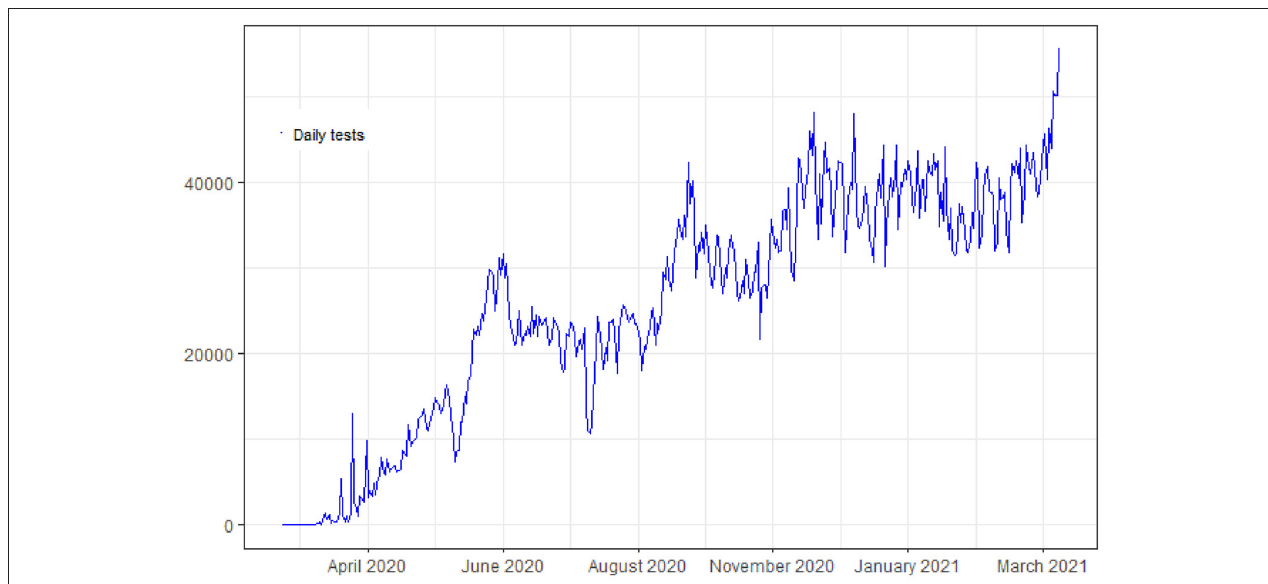
FIGURE 1 | Daily COVID-19 tests from February 2020 to March 2021 in Pakistan.